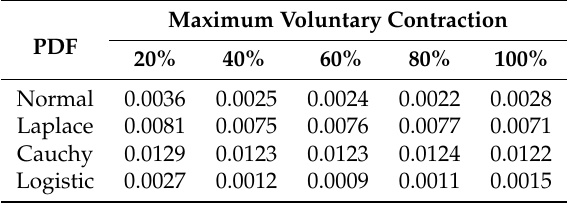
Table 4. The mean of the MAE features of each theoretical PDF for each percentile load level condition.